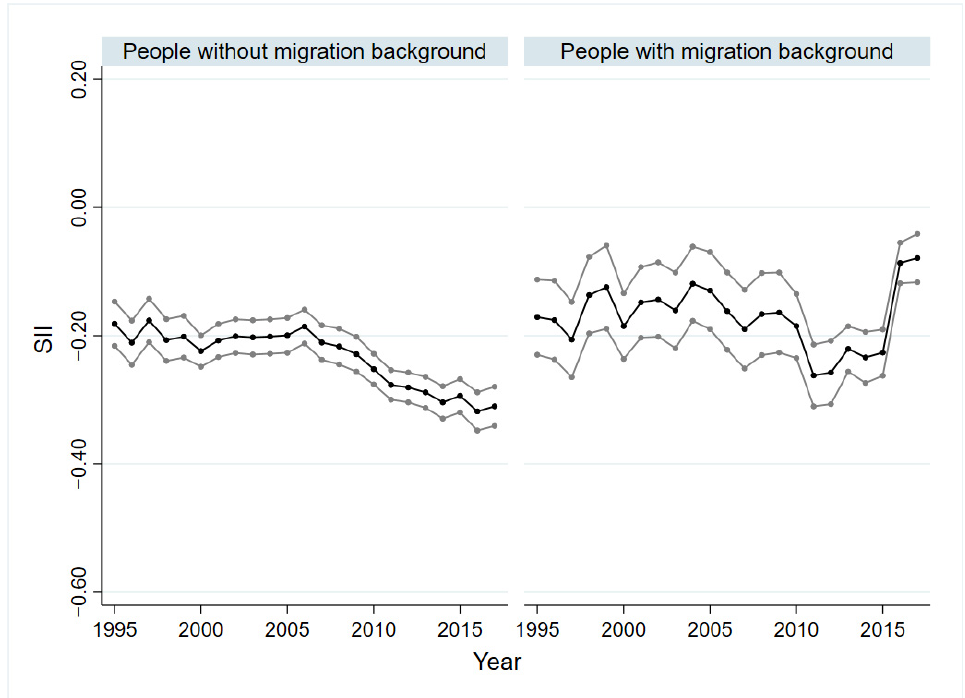
Figure 1. Absolute socio-economic inequalities in SRH in people with and without migration background, 1995–2017. SRH: self-rated health; SII: slope index of inequality; black line: regression coefficient; grey line: 95% confidence interval.